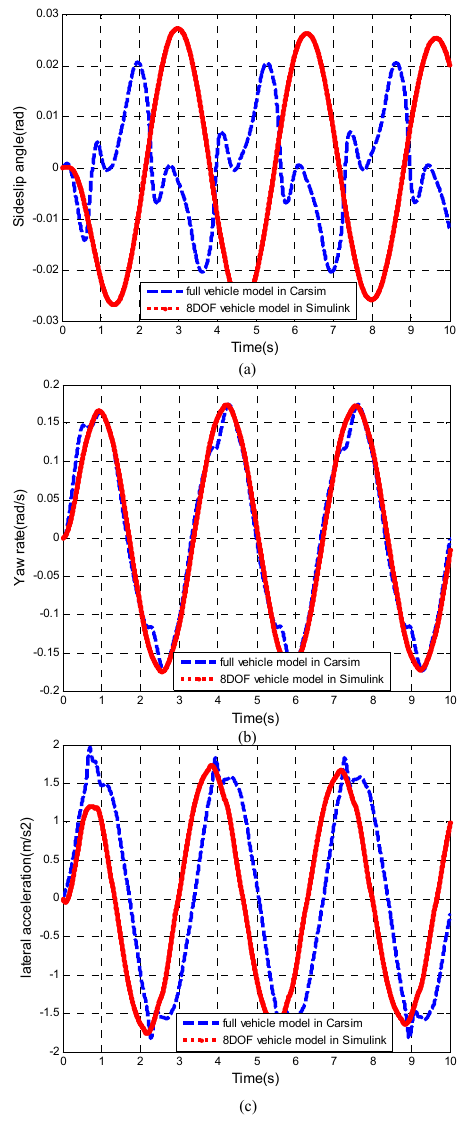
Figure 3. 8DOF vehicle model validation: ( a ) sideslip angle comparison; ( b ) yaw rate comparison; ( c ) lateral acceleration comparison.